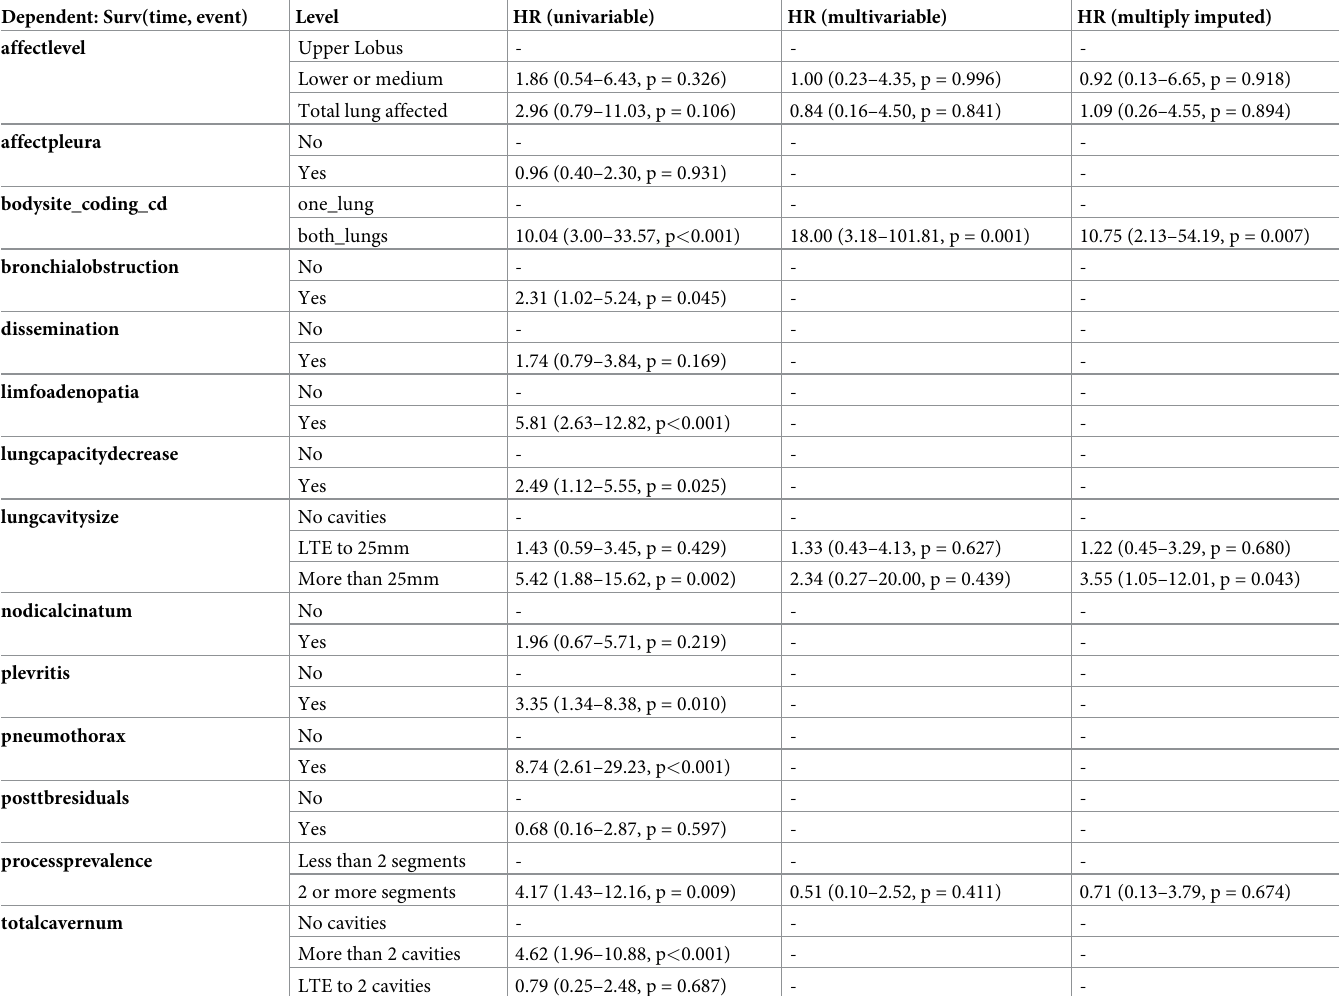
Table 2. Hazard ratios from univariate, multivariate, and multiply imputed multivariate cox proportional hazards regression. Dependent: Surv(time,